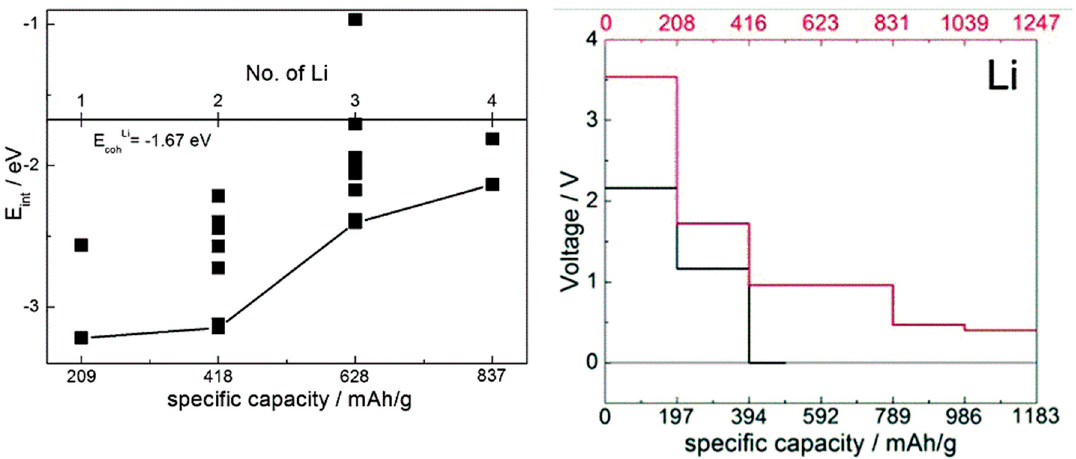
Figure 5. Left: computed interaction energy of Li with a TCNE molecule, with a hybrid functional. Different symbols correspond to different configurations. The distance from the black curve to the cohesive energy of Li gives an estimate of voltage. Adapted from [38] with permission from the PCCP Owner Societies. Right: computed voltage-capacity curves for lithiation of solid TCNE (red curve and axis) and LiTCNE MOF (black curve and axis), using a GGA functional. Adapted from [37] published by the PCCP Owner Societies.